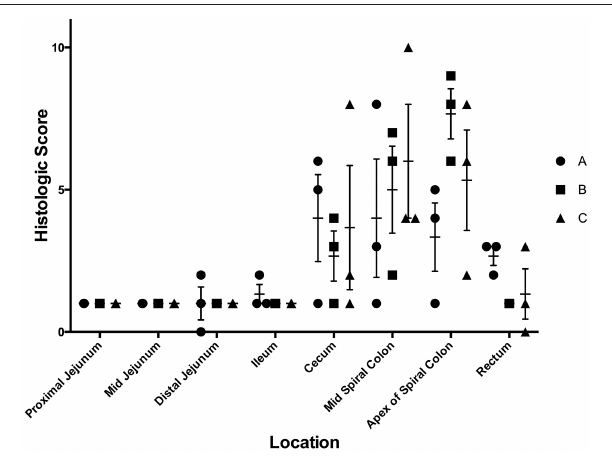
FIGURE 3 | Histologic scores from samples collected at necropsy on day 7 following inoculation with three separate isolates of S. 4,[5],12:i:- (A, B, C) in animal study #1. These scores depict the average histologic lesions, as determined by the ulceration, neutrophil infiltration, and crypt elongation and abscessation, and submucosal inflammation, at the time of necropsy on DPI 7. The mean of each isolate-tissue location combination is represented by the horizontal bar with the standard error represented by the vertical